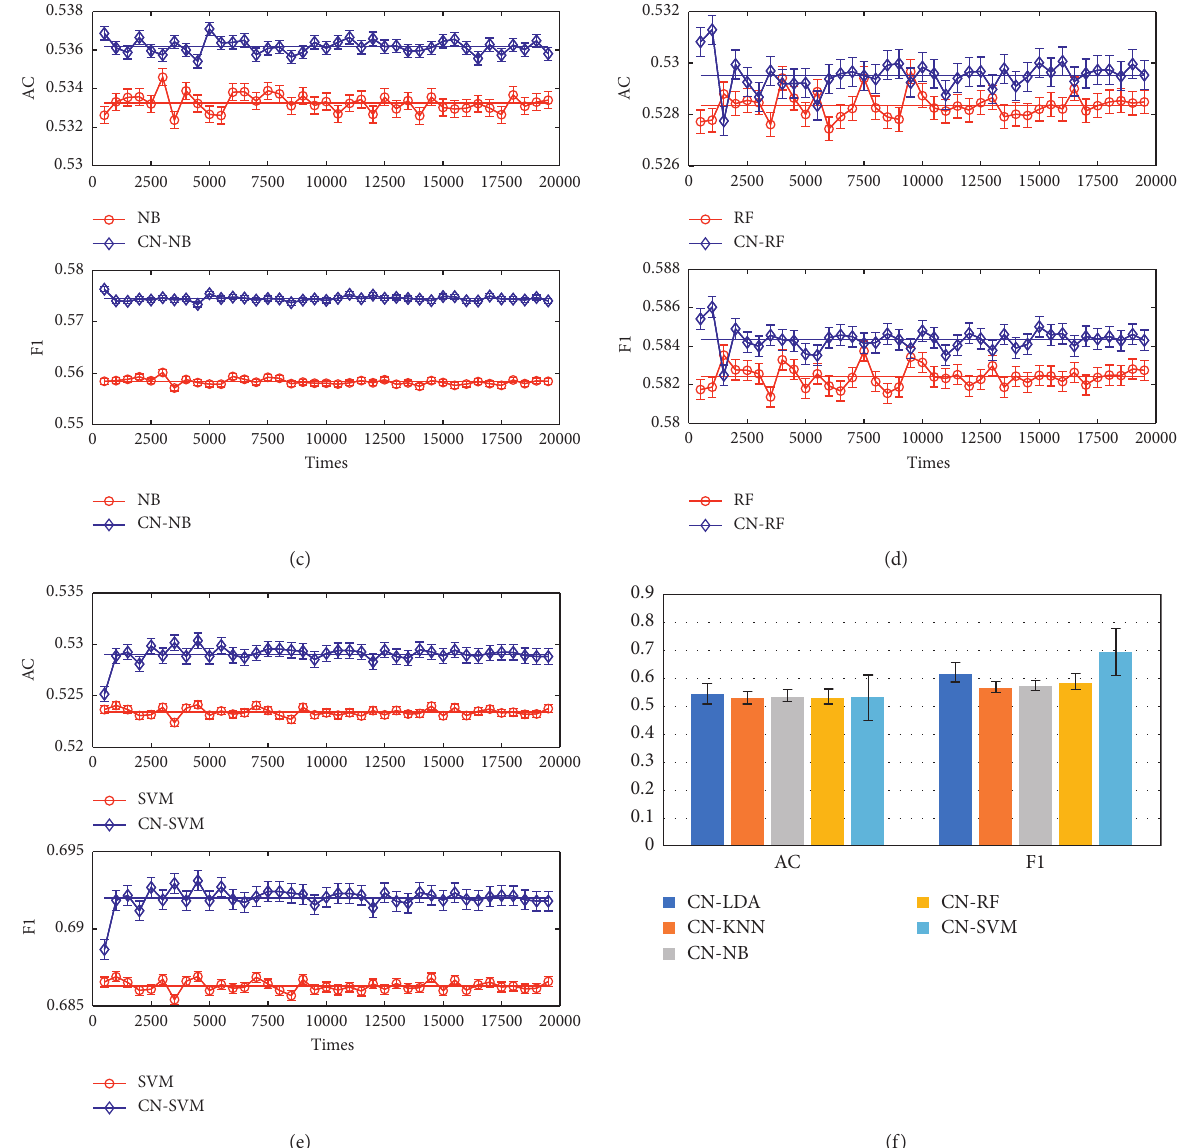
Figure 4: Comparison of the predicted results of different forecasting models on the fluctuation trend of carbon price in the EU carbon